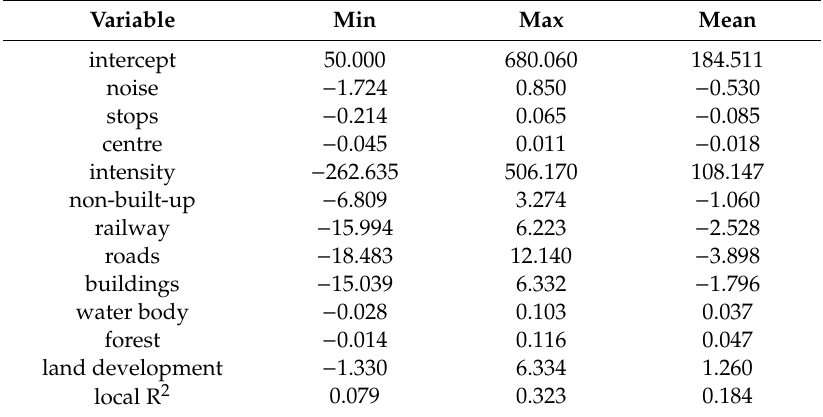
Table 9. General results of the geographically weighted